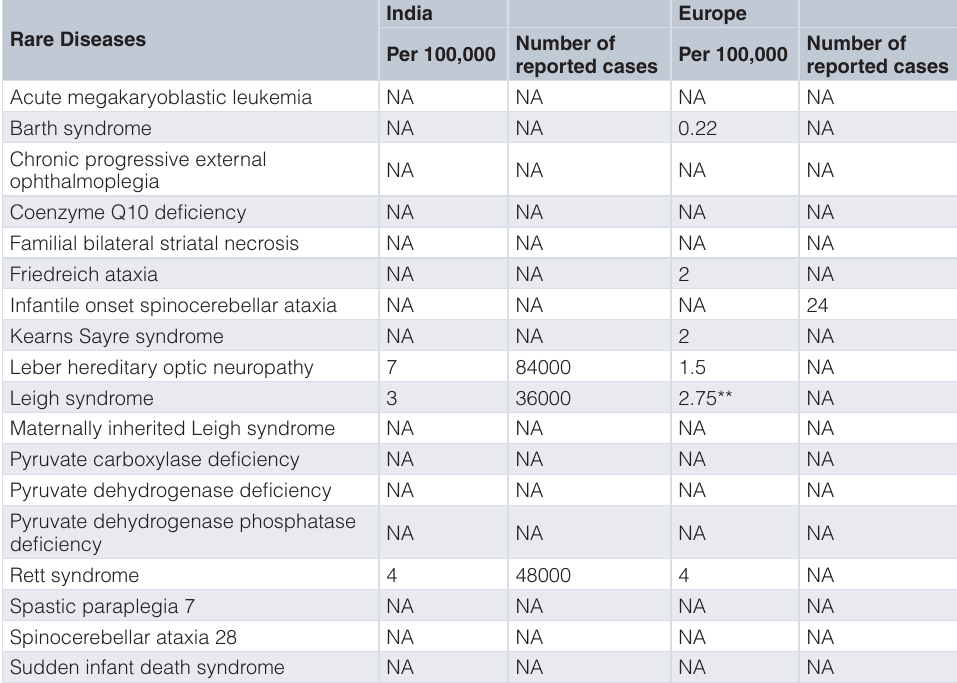
Table 2. List of rare mitochondrial diseases. The table provides a list of diseases that cause mitochondrial dysfunction and are also reported rare